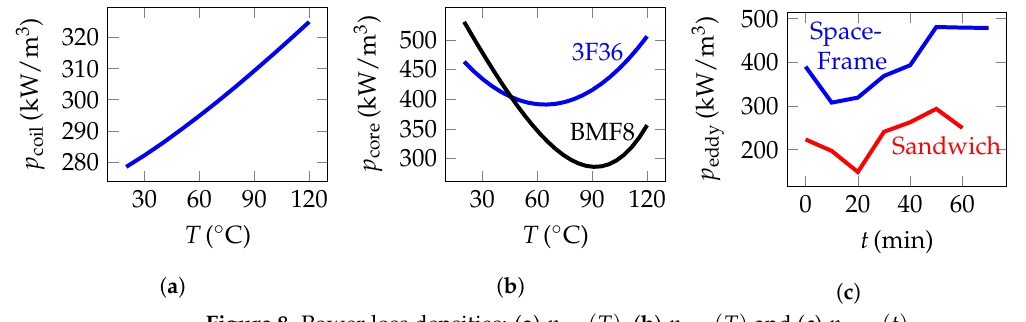
Figure 8. Power loss densities: ( a ) p coil ( T ) , ( b ) p core ( T ) and ( c ) p eddy ( t ) .